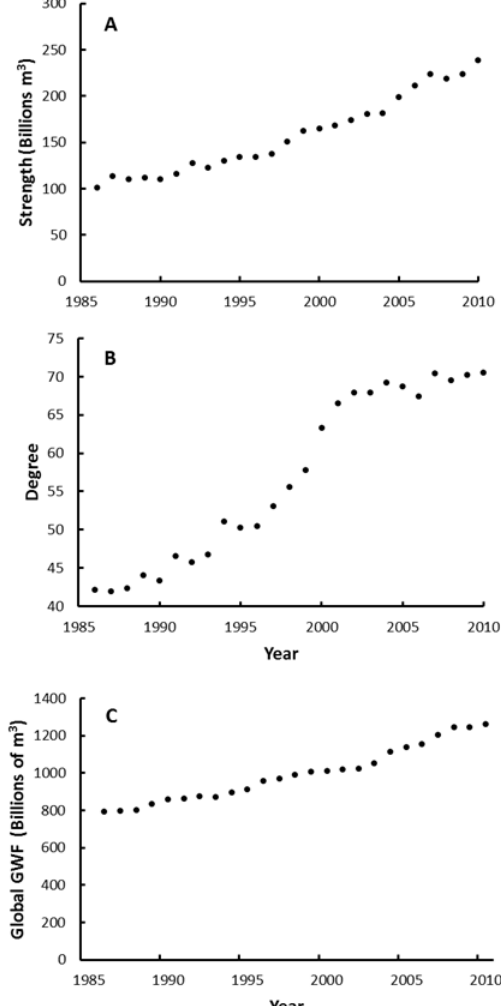
Fig. 4. (A) The total strength (m 3 yr − 1 ) of the global grey water trade increased over the 25yr period. (B) The average nodal degree in the network increased over the 25yr period. (C) The global total grey water footprint increased over the 25yr